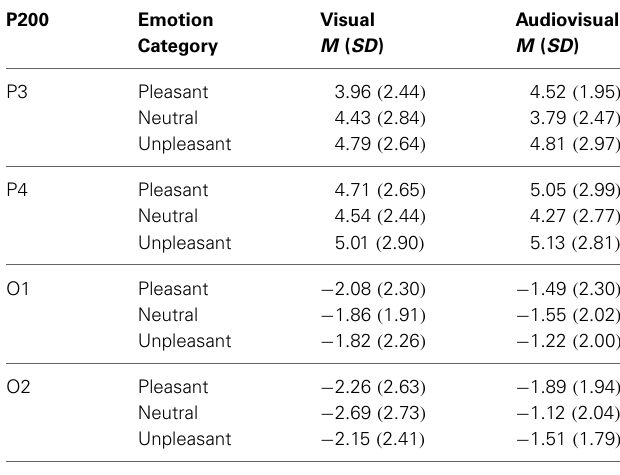
Table 3 | Mean and standard deviation for the P200 amplitude on parietal (P3,P4) and occipital electrodes (O1,O2) in response to visual and congruent audiovisual presentations.